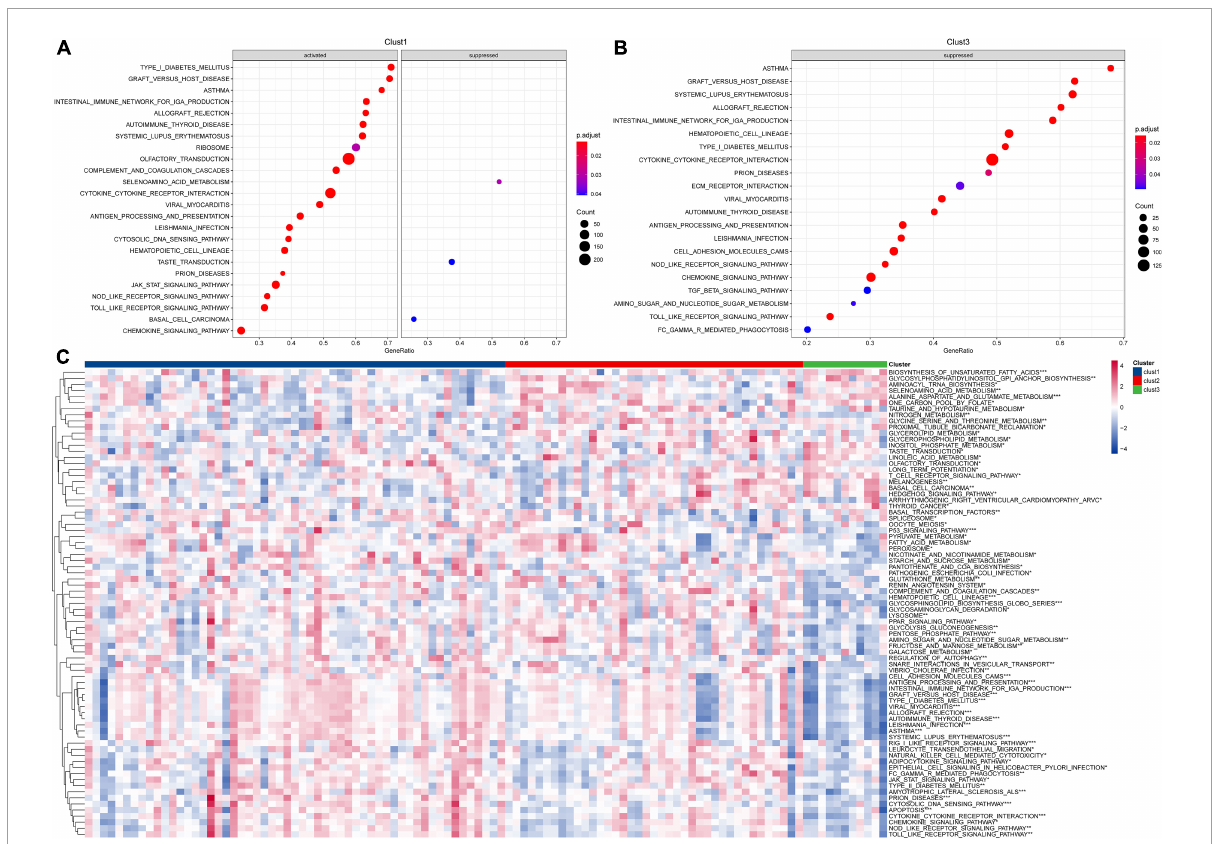
FIGURE2 Pathway analysis for molecular subtypes in ALL. (A) GSEA analysis of clust1 vs. no_clust1 in the Target dataset; (B) GSEA analysis of clust3 vs. no_clust3 in the Target dataset; (C) GSVA analysis of pathway enrichment scores for each of the three subtypes (* P < 0.05; ** P < 0.01; *** P < 0.001; and **** P <